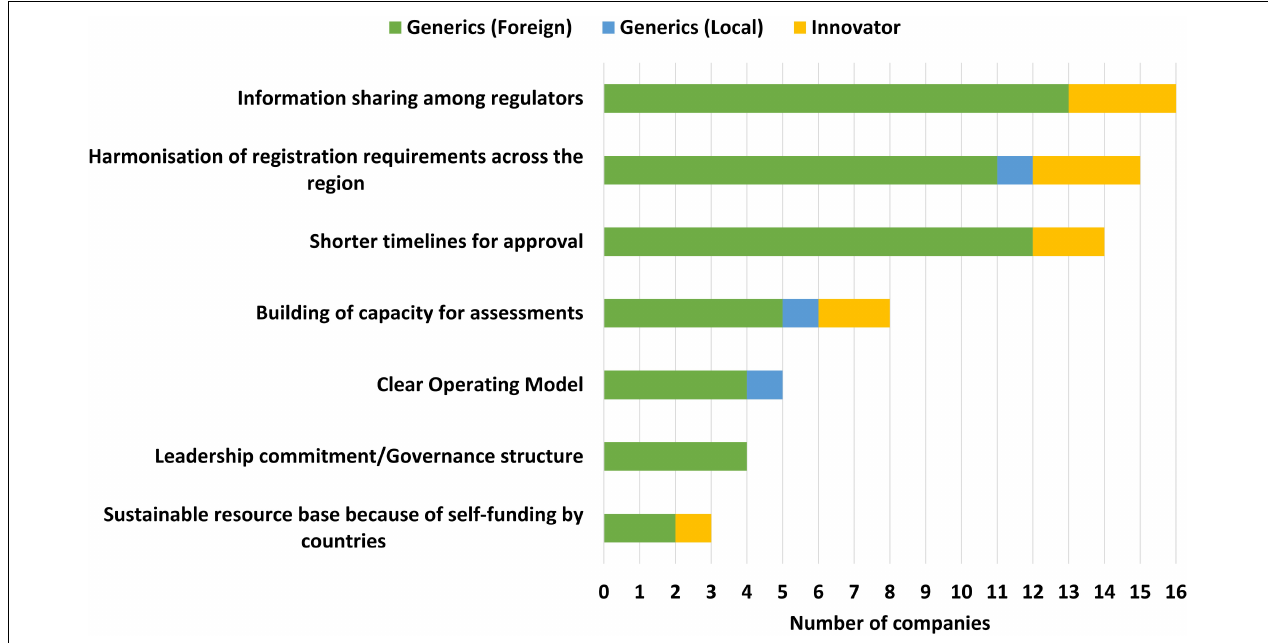
FIGURE 2 | Benefits of the ZaZiBoNa initiative according to pharmaceutical industry